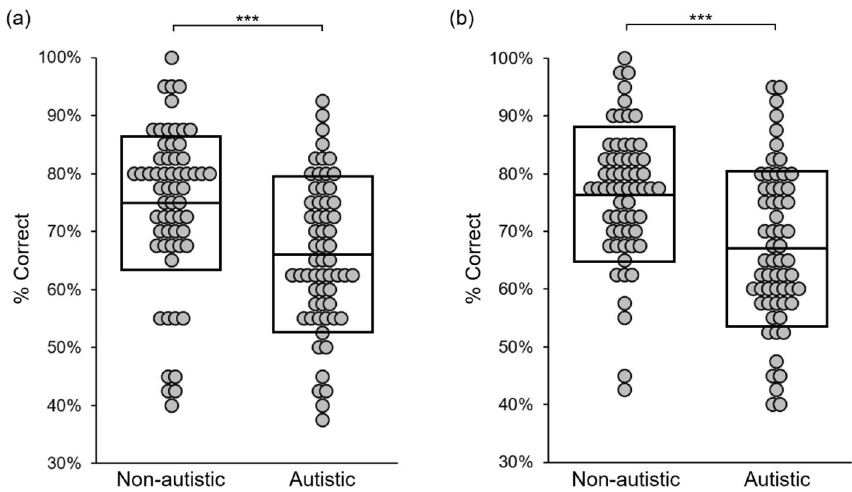
Figure 2. Results from Experiment 1 ( a ) and Experiment 2 ( b ). Boxes indicate group mean ± SD. ***denotes significance at p <